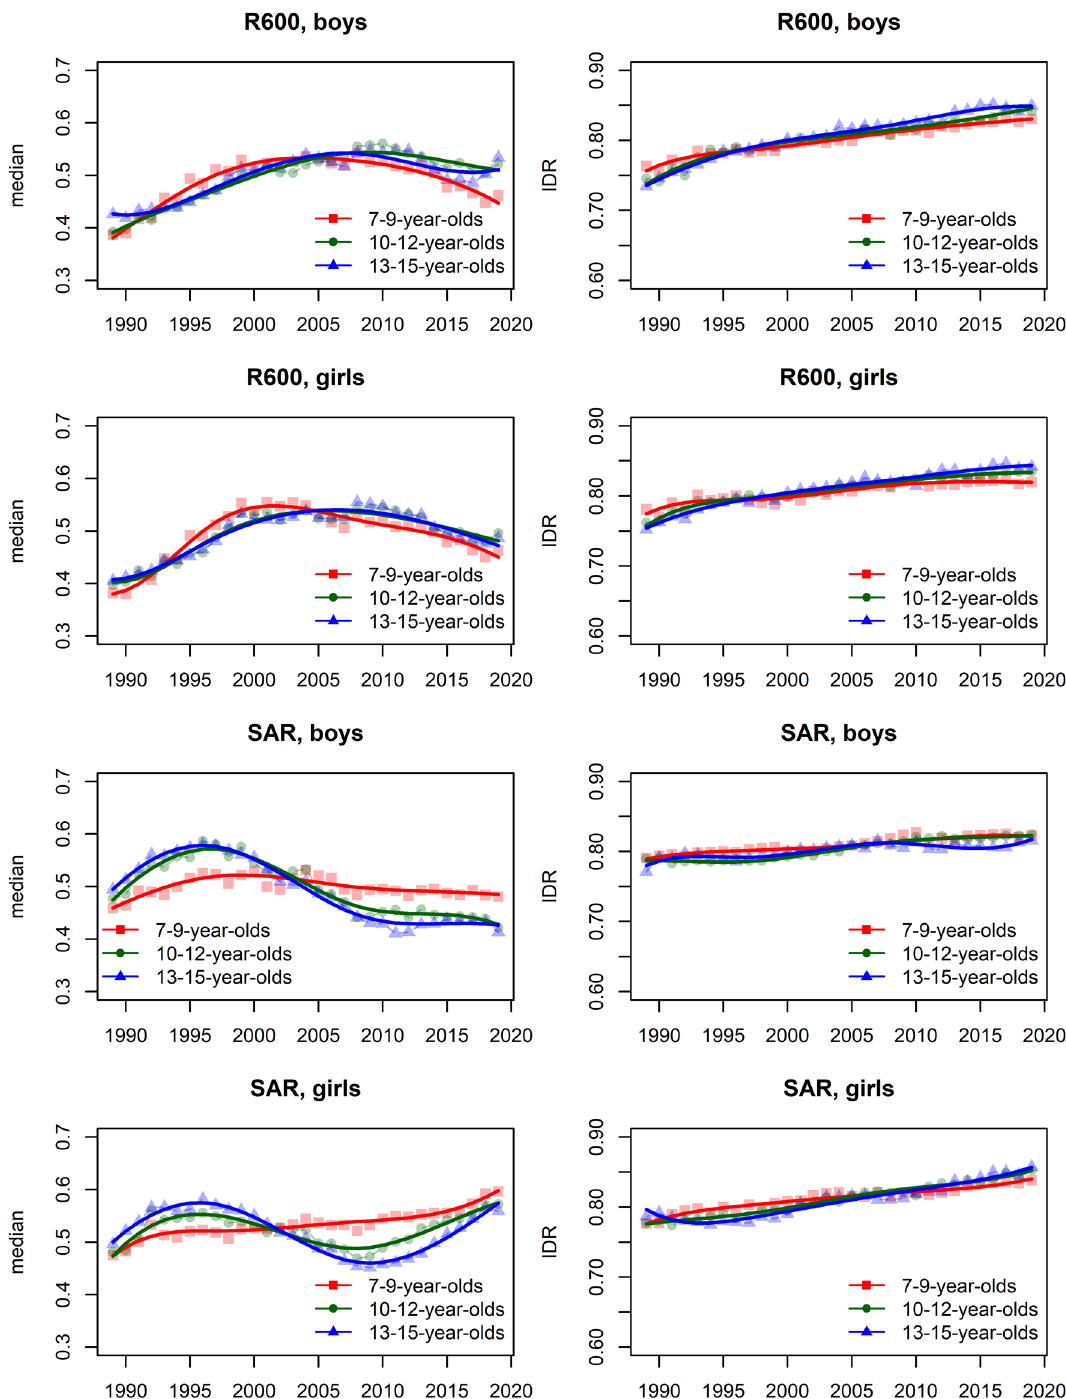
Figure 7. Time trends (medians and IDR) in the R600 and SAR between 1989 and 2019 by gender, across three age groups: 7–9 years, 10–12 years, and 13–15 years. Points and solid lines are the estimated values and smoothed estimated values, respectively, adjusted by region (the results are shown fixing the region to its mode). In the plots for R600 showing the estimated medians, the estimates below (above) 1/2 imply that the results were better (worse) than in the period 1989–2019 when comparing children of the same gender and age; for SAR the opposite holds. See Supplementary Information for more results including the uncertainty in the point